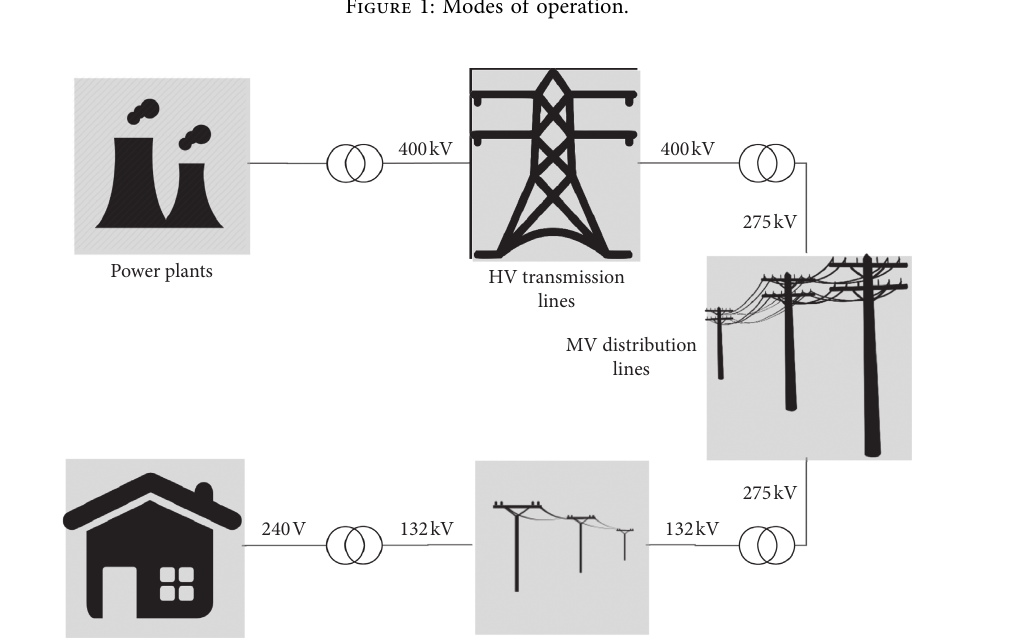
Figure 2: Example of a general structure of the public grid.